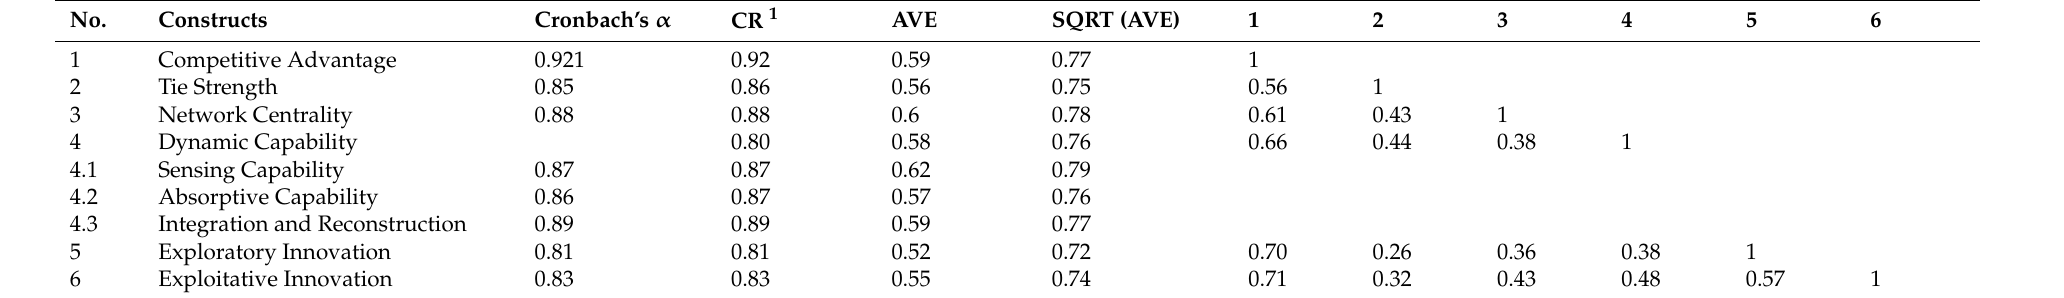
Table 1. The results of reliability analysis, validity analysis and